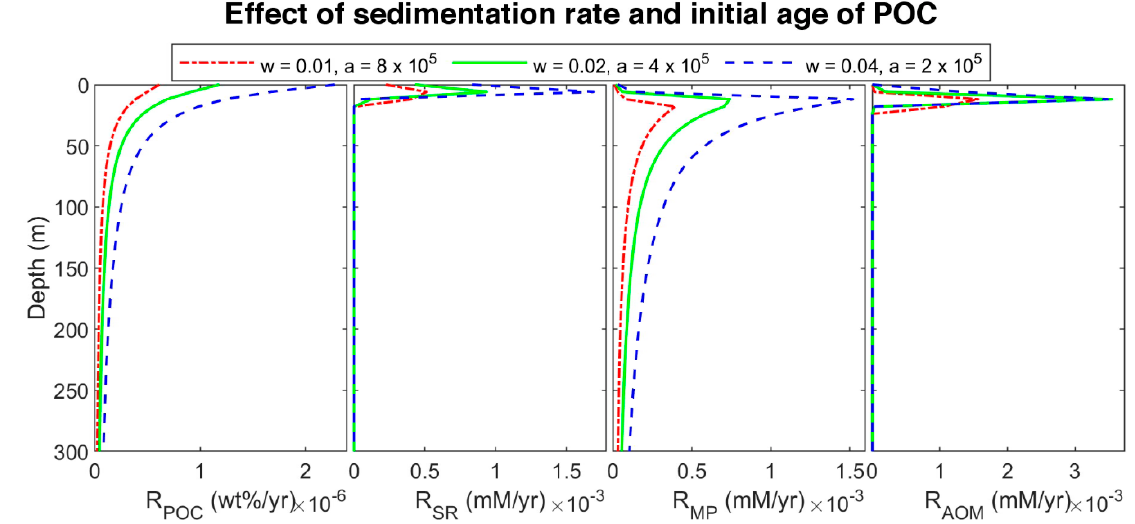
Figure 7. Rate profiles of modeled results at different sedimentation rates and initial ages of POC in the last time step of the model.